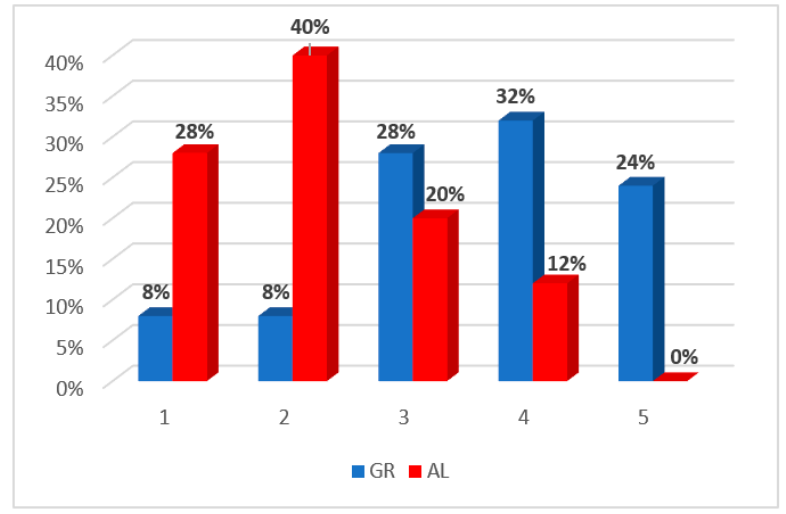
Figure 2. Contribution of the experience gained in the business acceleration program to the devel- opment of a different business idea, than the original one.